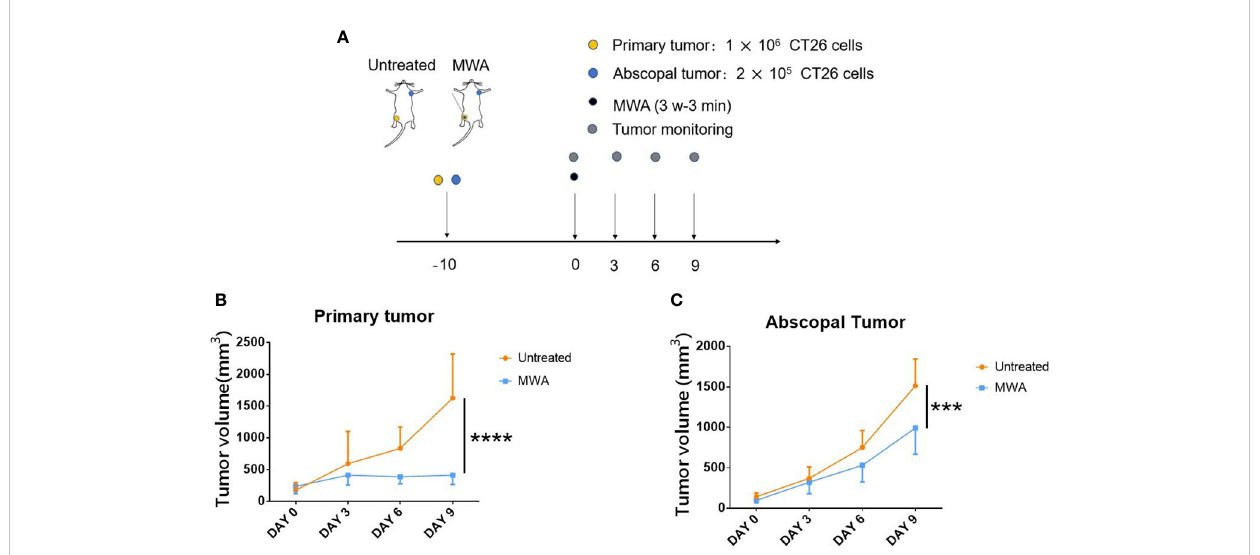
FIGURE 2 Abscopal effect in CT26 tumor-bearing mice was signi fi cantly induced by MWA at 3 w – 3 min. (A) Balb/c mice were inoculated with CT26 cells. When the tumor size attained 250 – 500 mm 3 in volume, tumor-bearing mice were treated with MWA (n = 6 in each group). (B) The growth of primary tumors was identi fi ed after MWA during the observation period. ****p < 0.0001. (C) The growth of abscopal tumors was determined following MWA during the observation period. ***p <